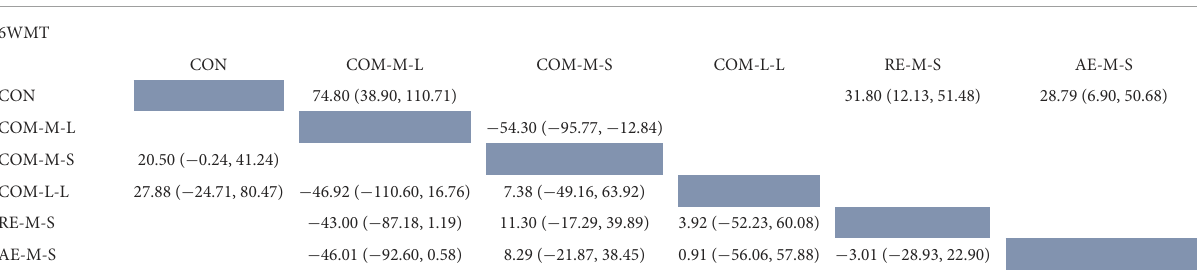
TABLE 5 Network meta-analysis matrix of results (6WMT). Outcome Comparison of treatments: Mean difference (95% confidence intervals) effect of intervention in each row compared with intervention in each column 6WMT CON COM-M-L COM-M-S